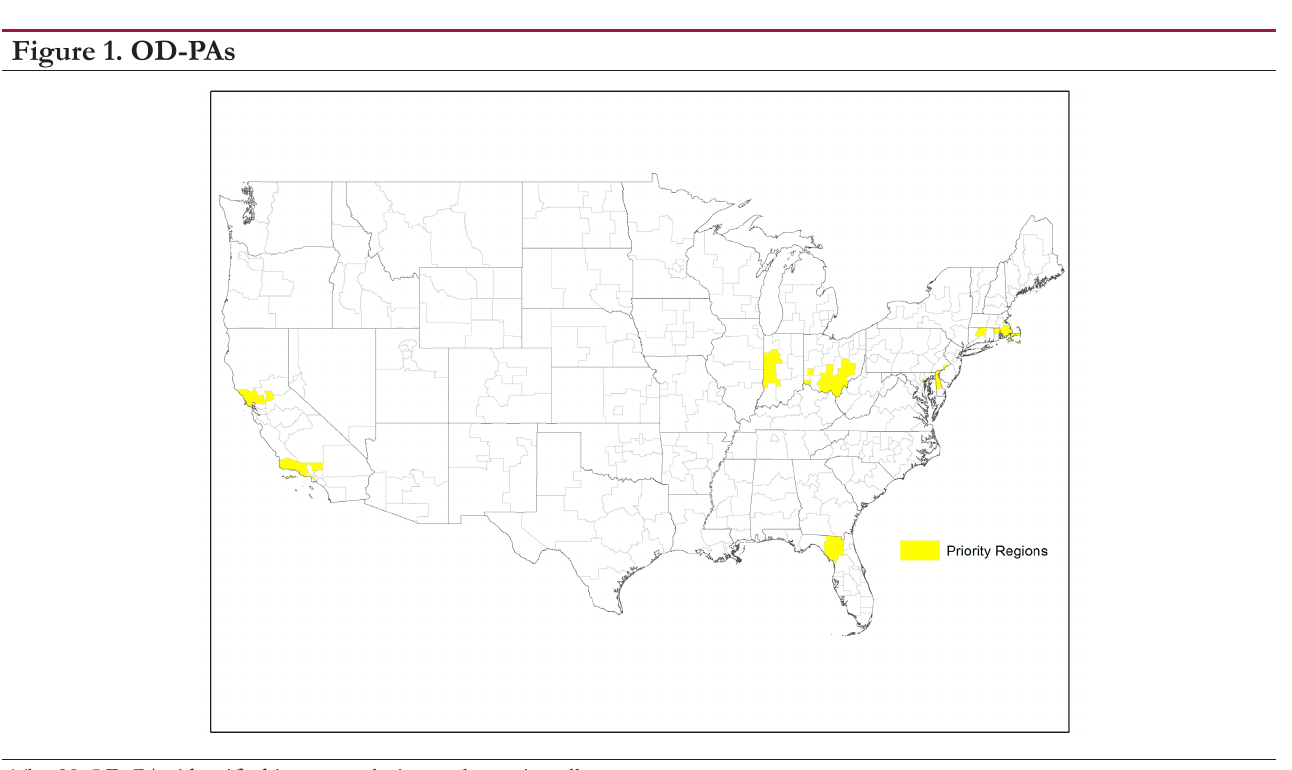
The 29 OD-PAs identified in our analysis are shown in